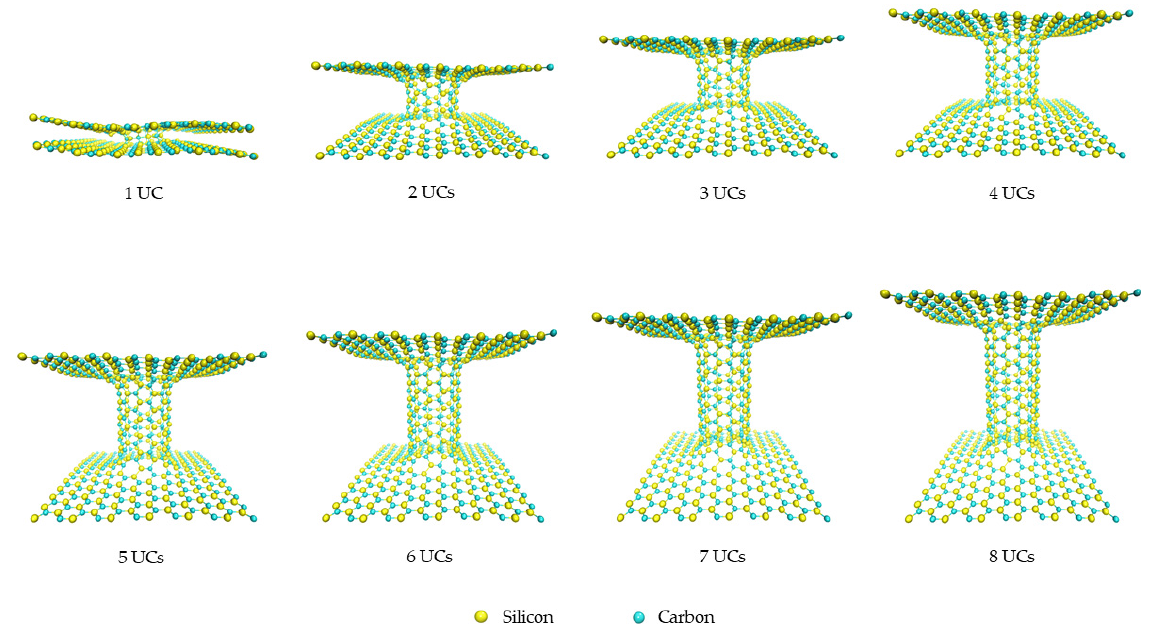
Figure 4. The 3D pillared SiC (6,6) nanostructures with various pillar lengths after full geometry optimization by the SCC-DFTB method. Table 2. Summary of the pillar diameters of 3D SiC and C nanostructures before and after geometry optimization by the SCC-DFTB method.